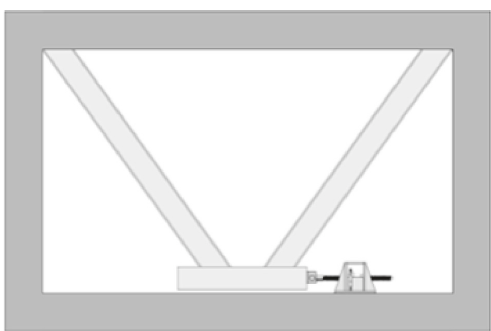
Figure 7: Schematic diagram of damper installation frame structure.